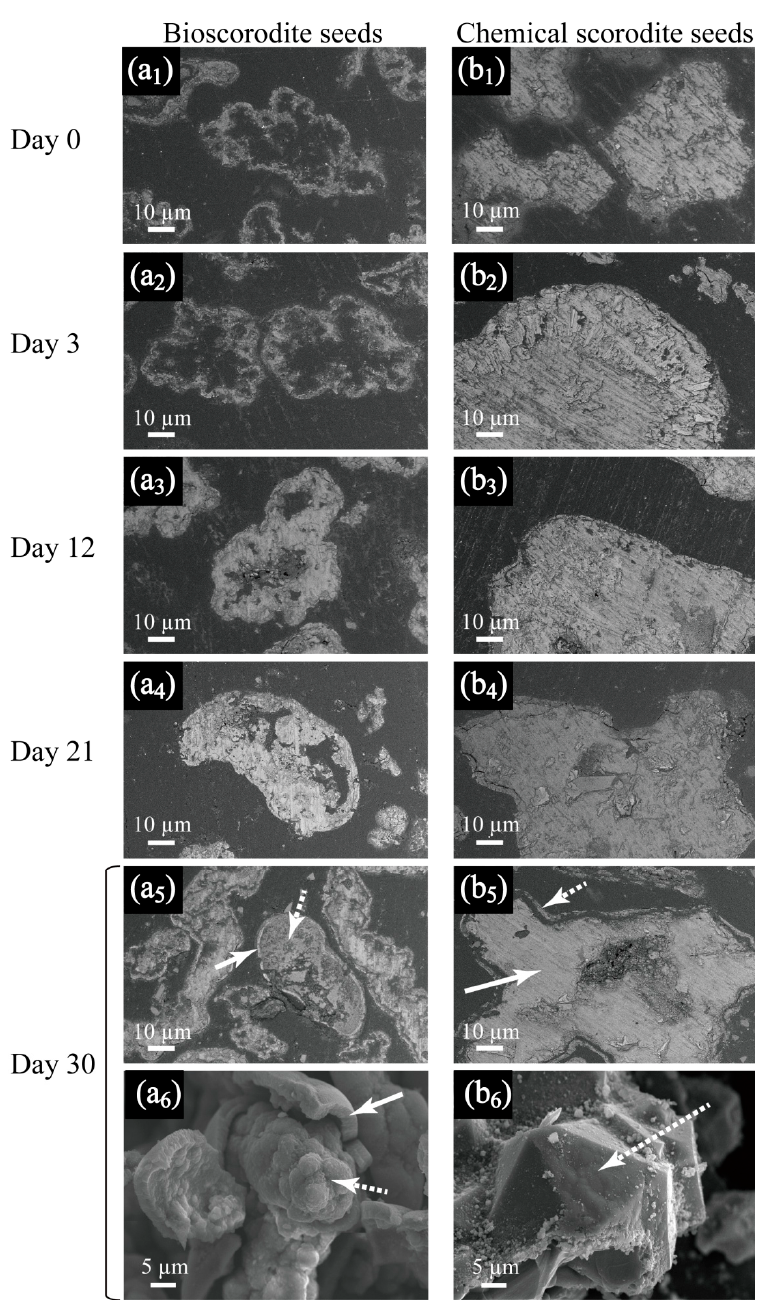
Figure 4. SEM cross section images depicting bioscorodite crystallization process (from day 0 to day 30) on bio- (from a1 to a5 ) or chemical- scorodite seeds (from b1 to b5 ), respectively. SEM whole view images of the resultant particles (day 30) on bio- ( a6 ) or chemical- scorodite seeds ( b6 ) are also shown. Solid and dotted arrows ( a5 , a6 , b5 , b6 ) indicate locations of seed crystals and fresh scorodite precipitates, respectively.